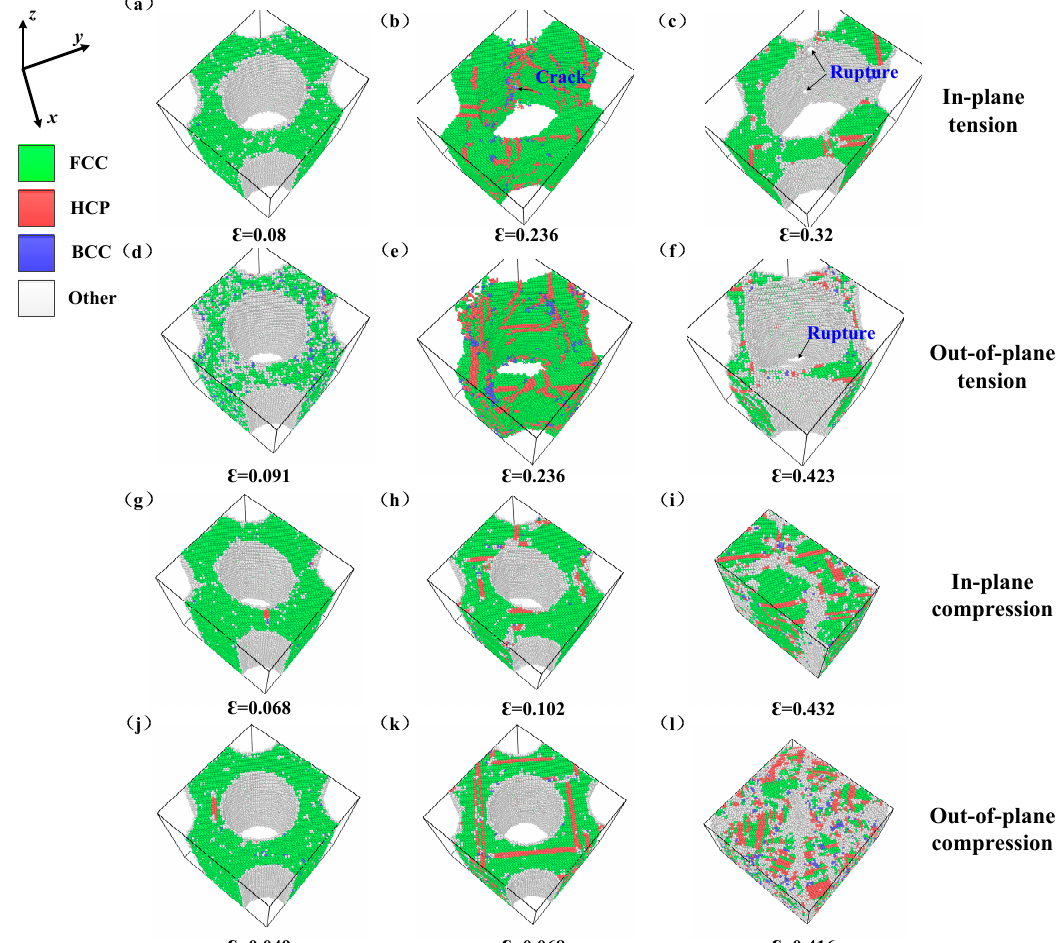
Figure 3. Atomic snapshots at specified macro loading strain: ( a , d , g and j ) peak stress, ( b , e , h and k ) stage of collapse or strain-softening, ( c , f , i and l ) densification or rupture of samples. Identification of atomic configurations is based on common neighbor analysis (CNA) and four types of atoms are painted in different colors: green for face-centered-cubic (FCC) atoms, blue for body-centered-cubic (BCC) atoms, red for hexagonal close-packed (HCP) atoms and gray for non-12-coordinated atoms.